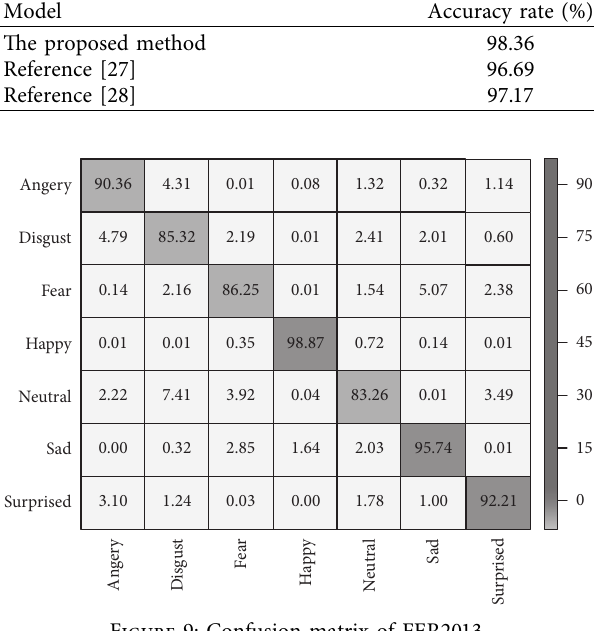
Figure 9: Confusion matrix of FER2013.